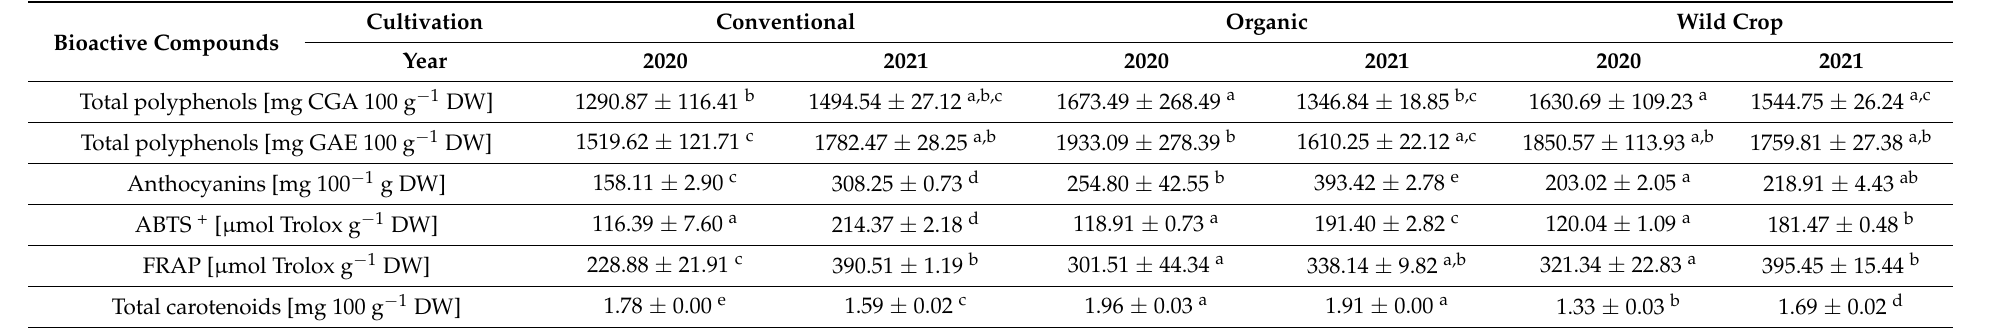
Table 4. Total polyphenol, carotenoids, and anthocyanins content, as well as antioxidant activity of the fruits of three raspberries cultivations at different